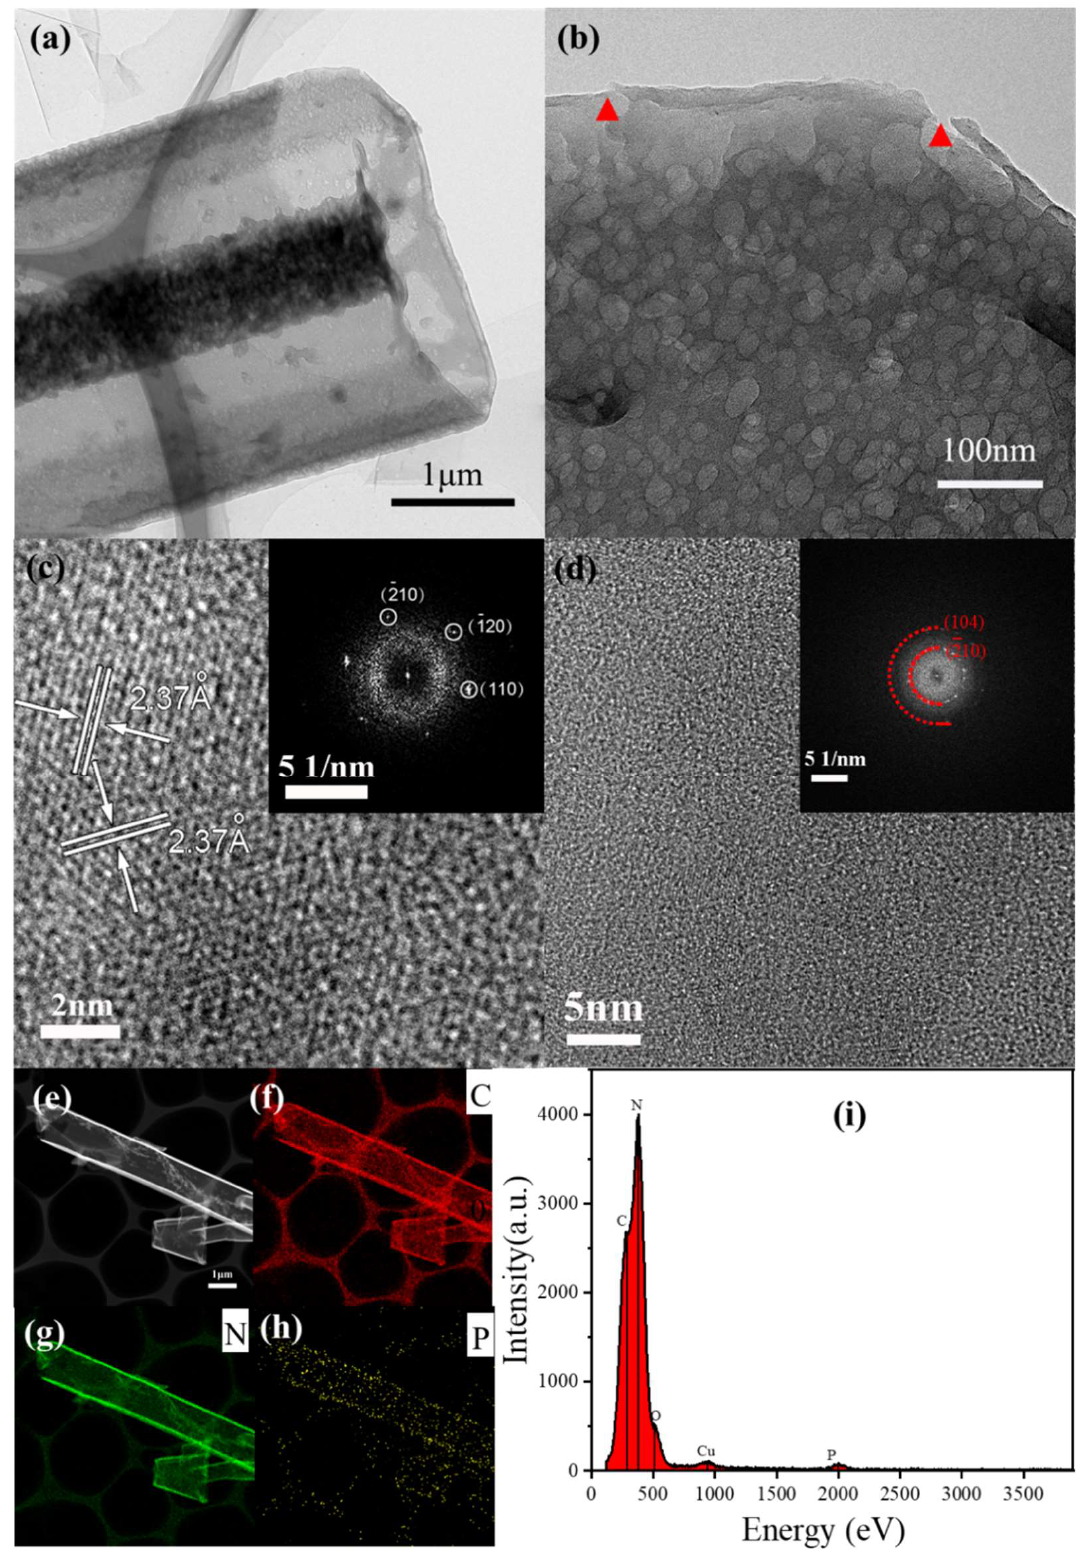
Figure 3. The TEM images ( a , b ) and HRTEM images ( c , d ) of the 0.9P-CNT sample, the inset is the corresponding selected area electron diffraction image, HAADF-STEM image and element mapping images of C, N, and P for the 0.9P-CNT sample ( e – h ), EDX spectrum of the 0.9P-CNT sample ( i ).